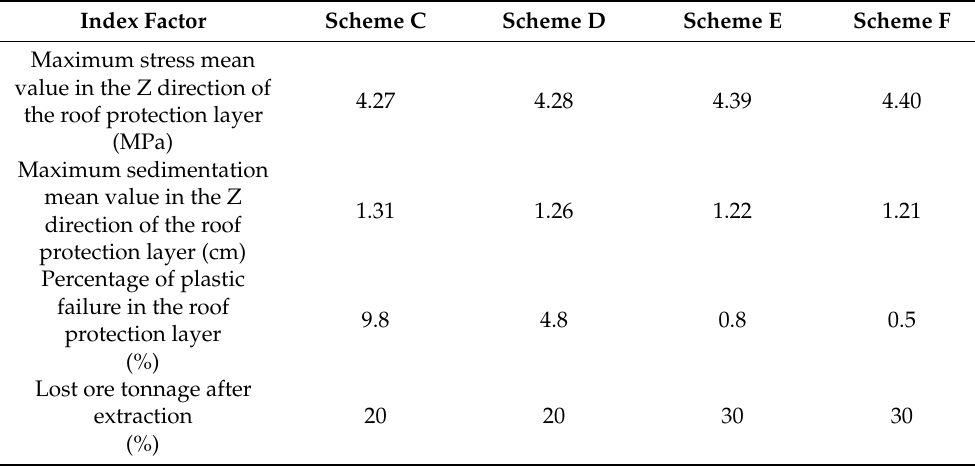
Table 13. Quantitative indicators of each top protection layer retention